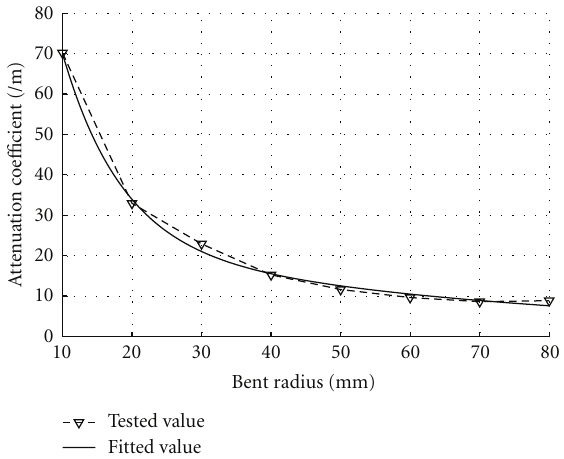
Figure 7: Attenuation coe ffi cient of SEOF in air.